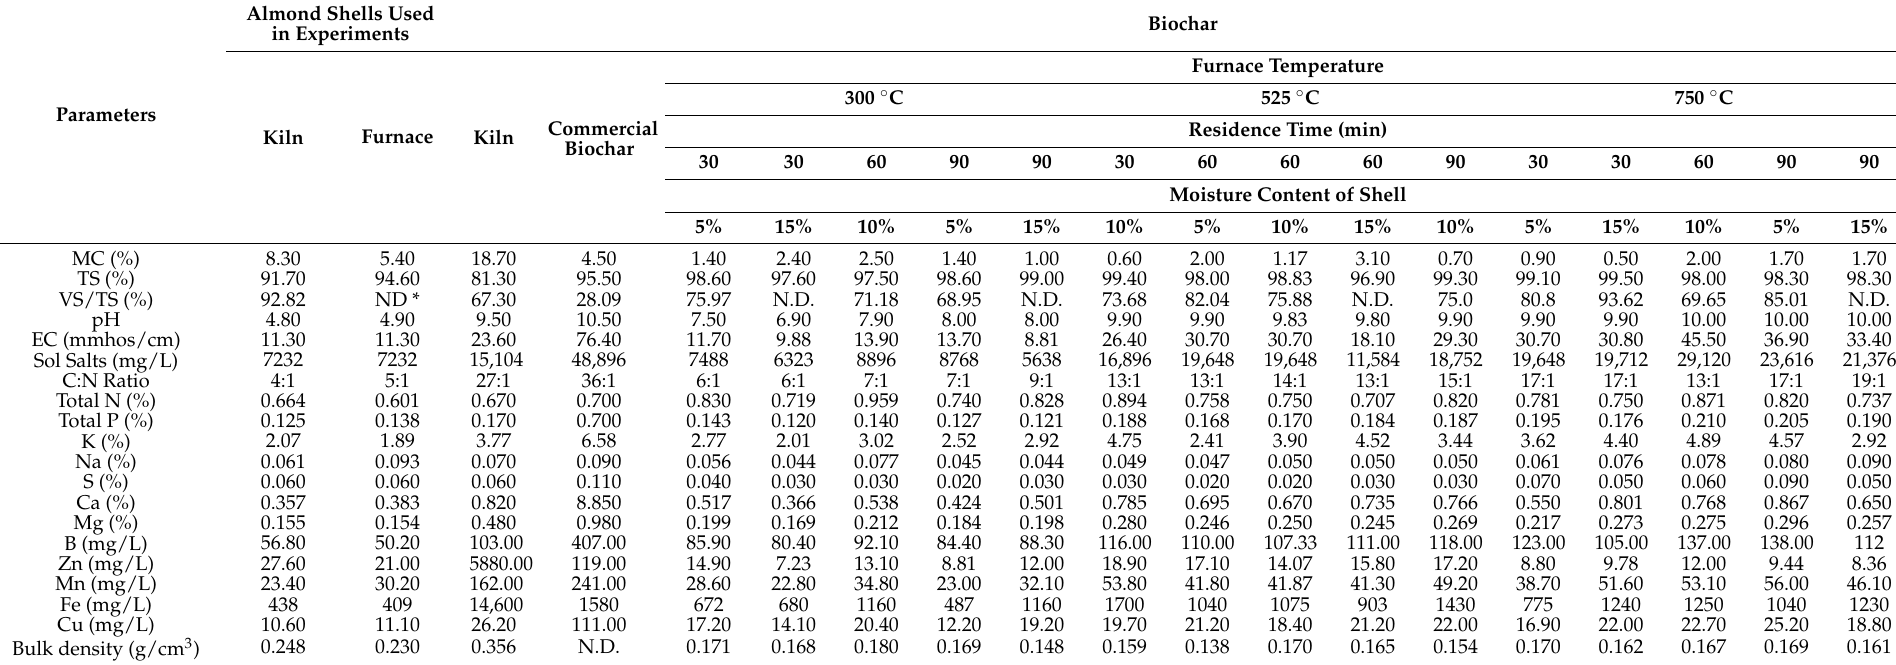
Table 1. Characteristics of almond shell feedstock and